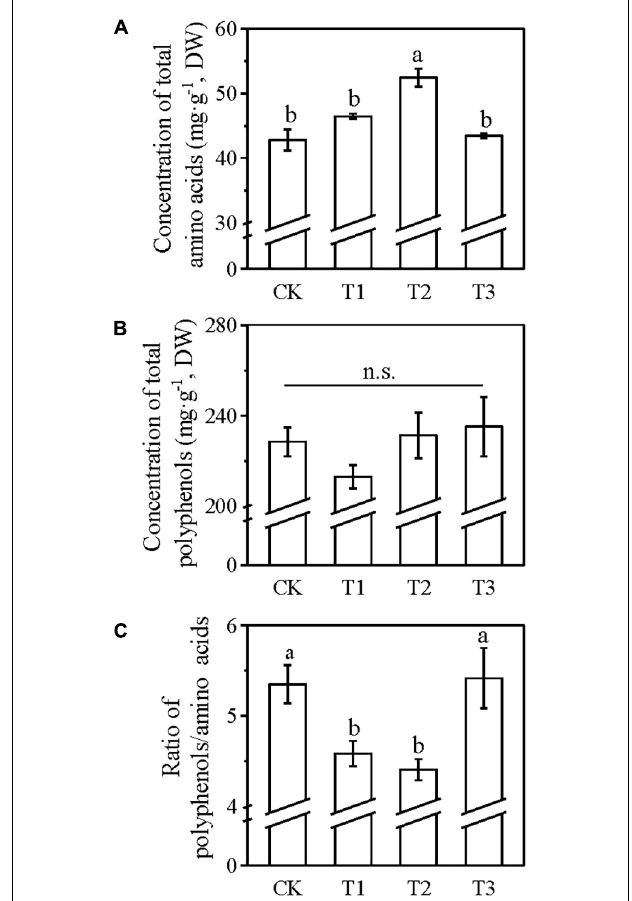
FIGURE 5 | The effect of different types of foliar fertilizers on the concentrations of the total amino acids (A) , polyphenols (B) , and the polyphenol/amino acid ratio (C) of spring tea. DW. T1, foliar application of amino acid liquid fertilizer; T2, foliar application of 2% (w/v) urea; T3, foliar application of a commercially available auxin-containing fertilizer; CK, foliar application of water. Values were shown as means ± SE ( n = 3). Lowercase letters indicated significant differences ( P < 0.05; ANOVA, followed by the Duncan test). n.s., no significant